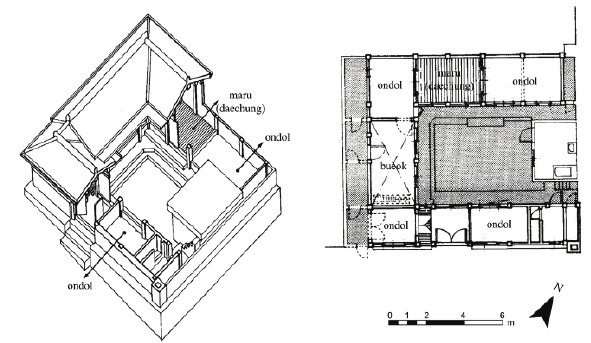
Figure 7. Typical urban hanok constructed between the 1930s and the 1960s in Seoul (source: Kwon et al., 2014)